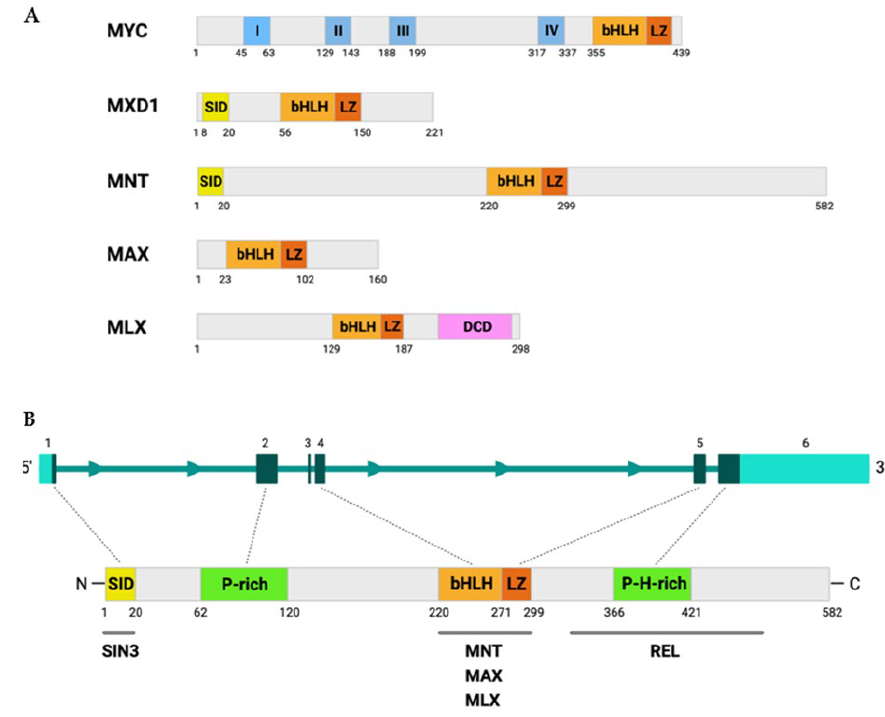
Figure 1 . MNT and MYC protein structure . ( A ) Comparison between MYC, MXD1, MNT, MAX, and MLX protein sizes and domains. The canonical isoforms are shown; specifically, the p22 isoform for MAX and the gamma isoform for MLX. MYC boxes are represented in blue with the numbers I–IV. ( B ) The MNT gene structure is schematized at the top, with boxes representing the six exons, and a scheme of the MNT protein at the bottom. The MNT exons that encode the most important regions are indicated as boxes, and the dotted lines connect the exons with the corresponding protein domains. The main MNT-interacting proteins are shown at the bottom. SID: SIN3 interacting domain; P-rich: proline-rich sequence; bHLH: basic helix–loop–helix; LZ: leucine zipper; P-H-rich: proline and histidine-rich region; DCD: dimerization and cytoplasmic localization domain. Figures were created with BioRender.com (Toronto, ON, Canada).